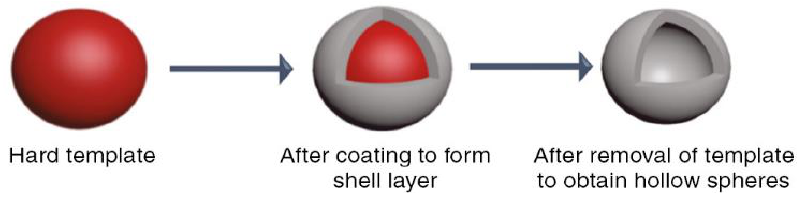
Figure 1. Hard templating route for hollow silica [16].